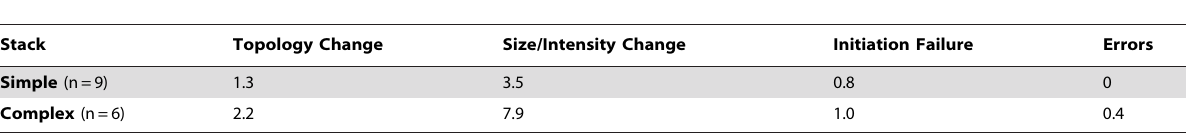
Table 1. Rate and Reasons of User Intervention in